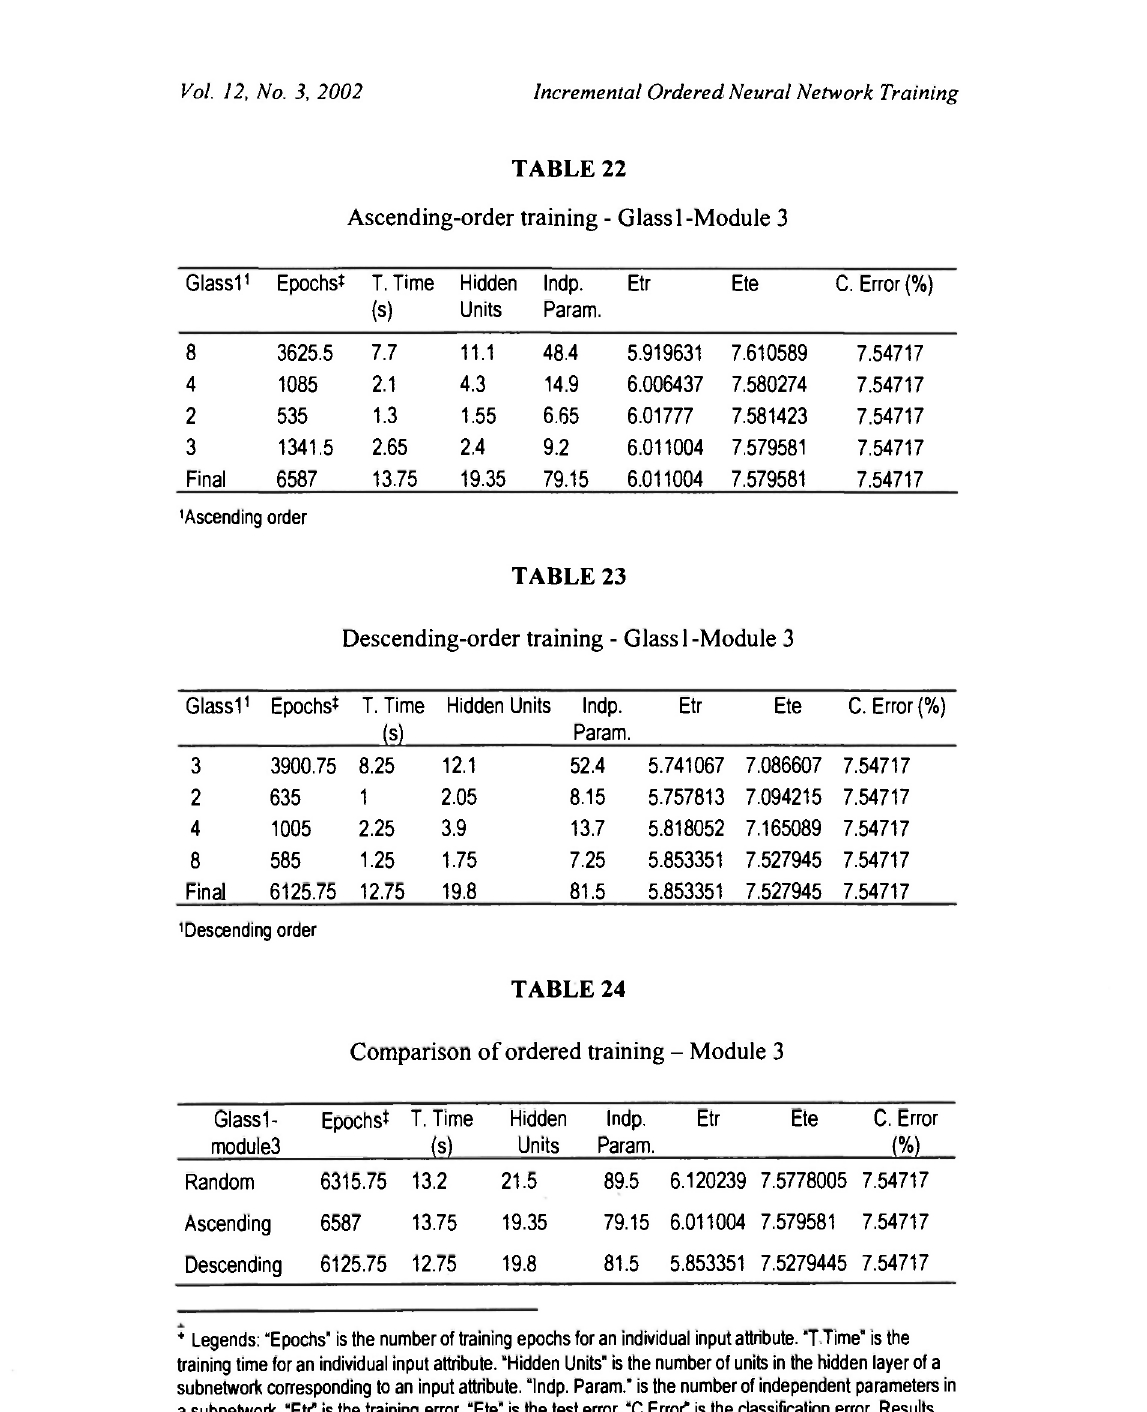
Comparison of ordered training - Module